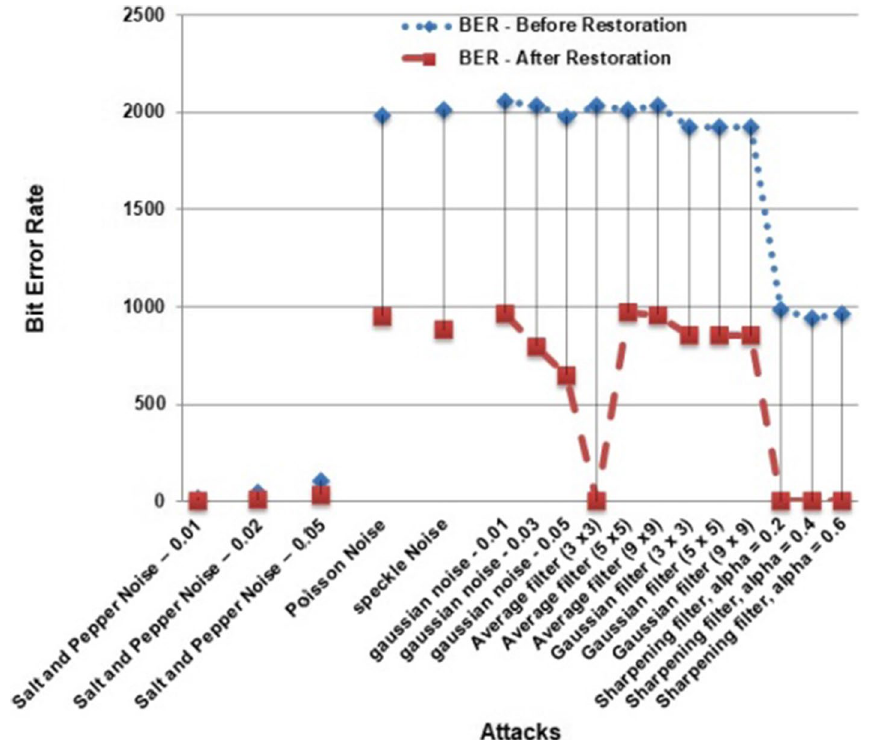
Fig. 11 Attacks vs. bit error rate